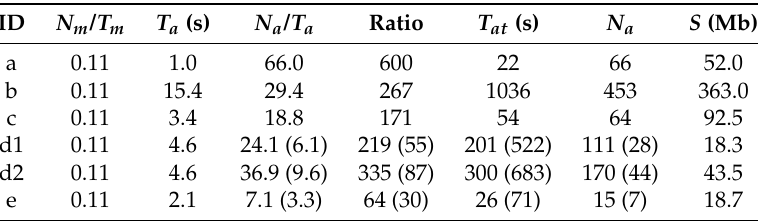
Table 4. Processing time for manual and automatic methods. T a is the time taken by the automatic method to generate the CM mask in a single core computer. T at is the total processing time including CM mask generation, box enclosing, box partition, quantification of morphological CM measures, CX43 characterization and statistical analysis. N a and N m denote the number of CMs in the automatic and manual masks, respectively. S is the summed size of the three channels in the image. N a / T a and N m / T m are the average number of CMs delineated per s by the automatic method and by a human expert in the field using advanced graphics tools, respectively. In brackets, the results obtained for rat images with the automatic method working in supervised mode are